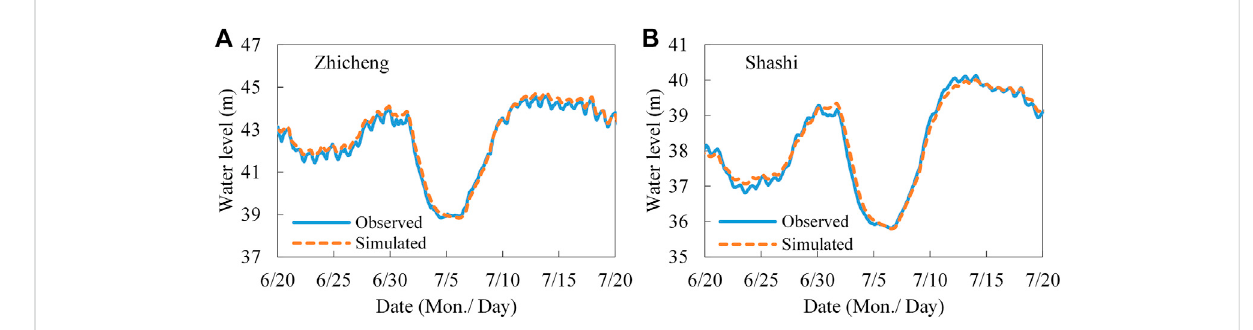
FIGURE 3 Simulated fl ood process in year 2017: (A) Zhicheng; (B) Shashi station.